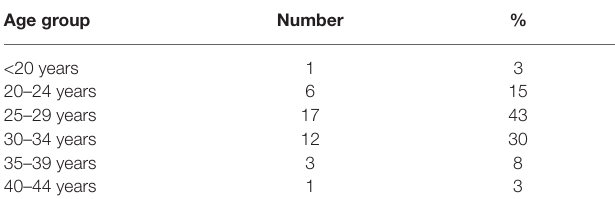
Values are mean ± SD.